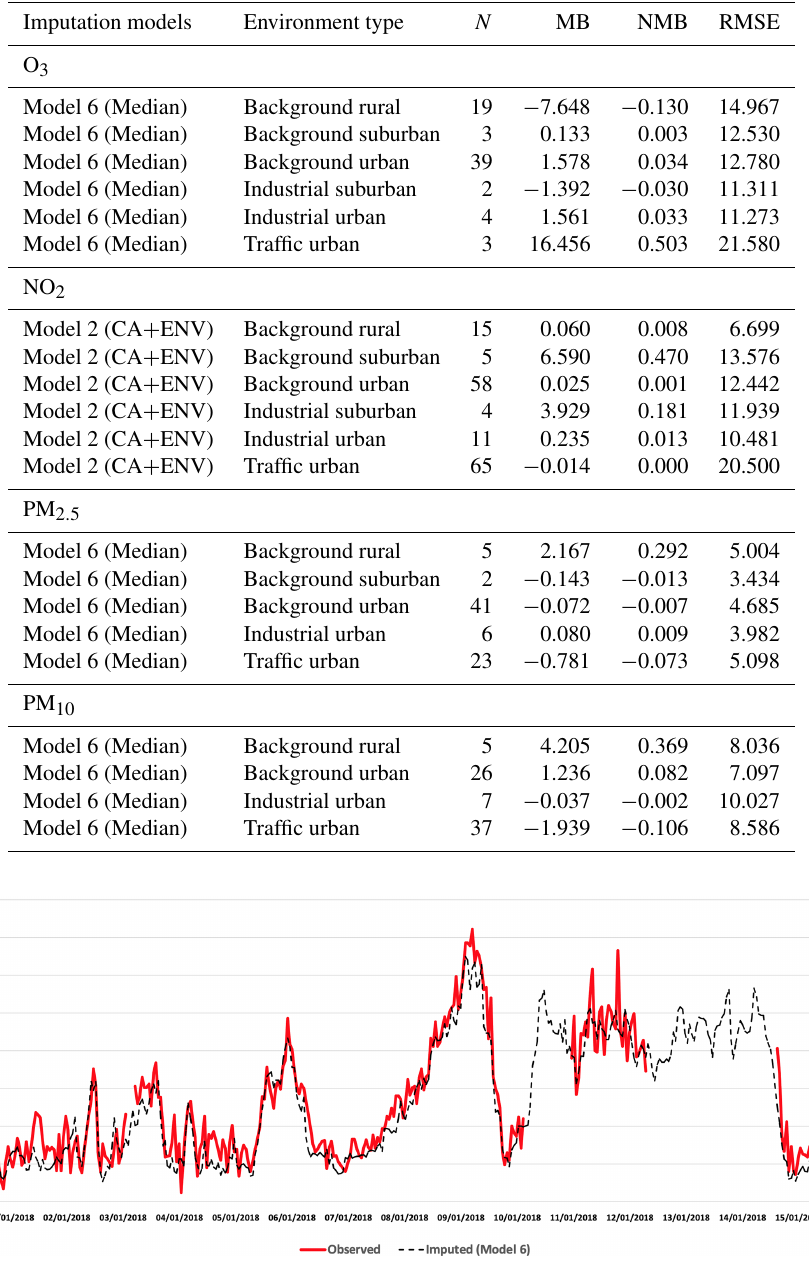
Table 2. Performance of the hourly pollutant concentration imputation models using model 6 (Median) for O 3 , PM 2 . 5 , and PM 10 and model 2 (CA + ENV) for NO 2 based on statistical measures for all station environment types for all pollutants.